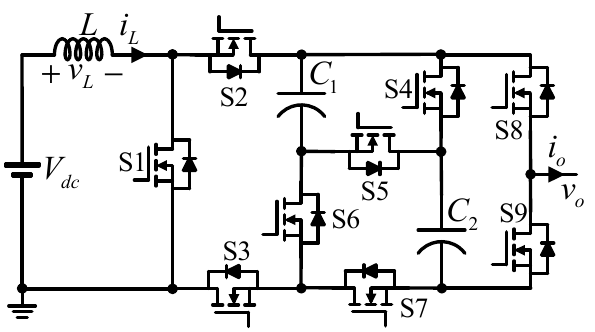
Figure 1. Circuit configuration of the proposed five-level inverter. Figure 1 . Circuit configuration of the proposed five-level inverter.